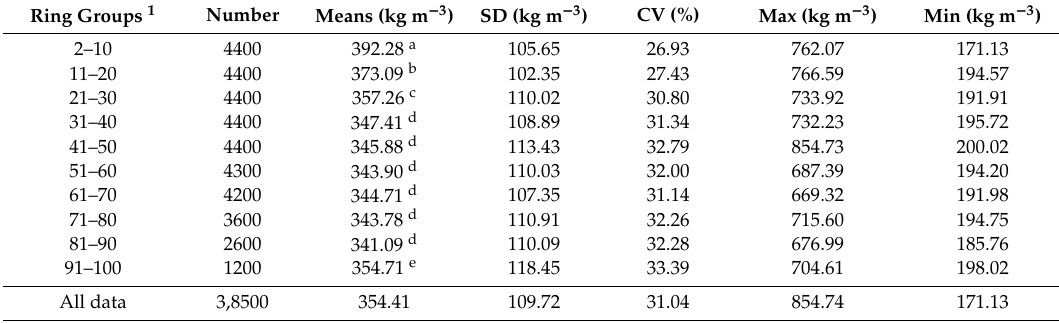
Table 2. Descriptive statistics (SD, CV, max and min) of wood density at selected ring groups in 44 T. occidentalis